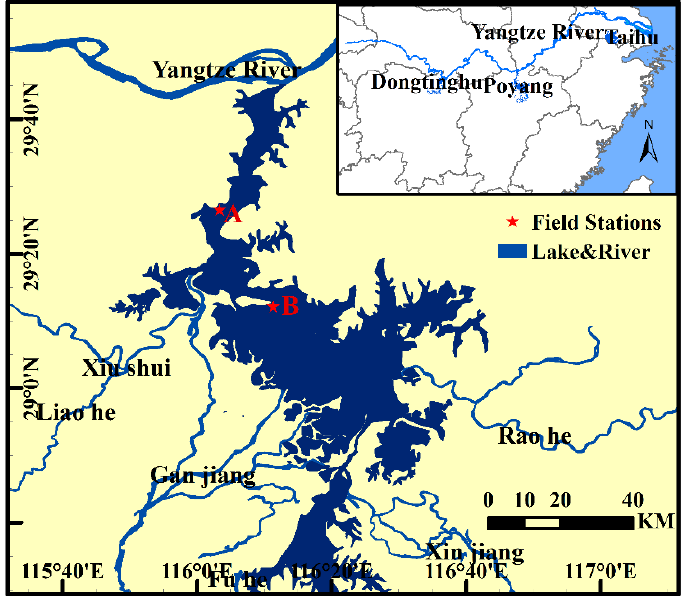
Figure 1. Location of Poyang Lake. The lake has five main tributaries and connects to the Yangtze River at Hukou. Red stars represent the field stations